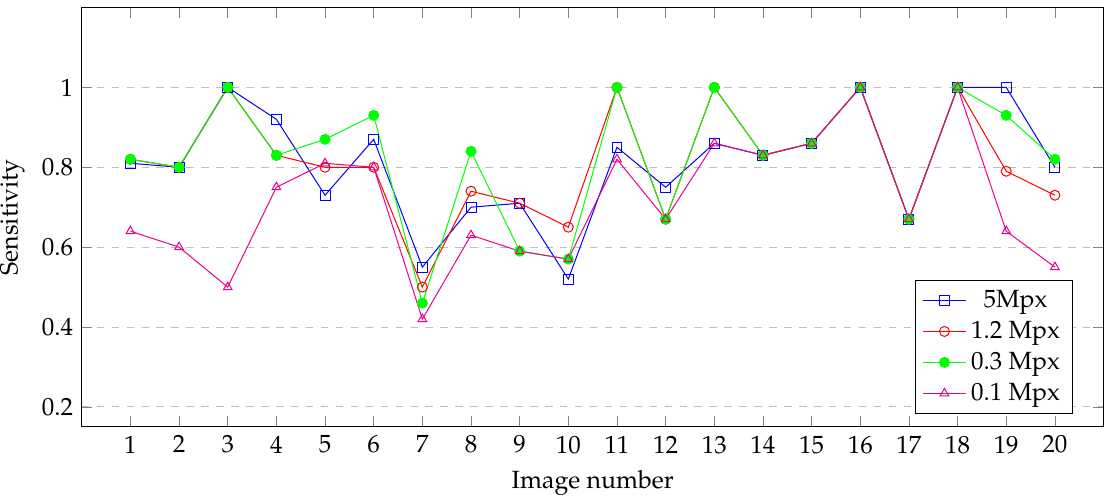
Figure 10. Sensitivity achieved for the bee identification process for different camera